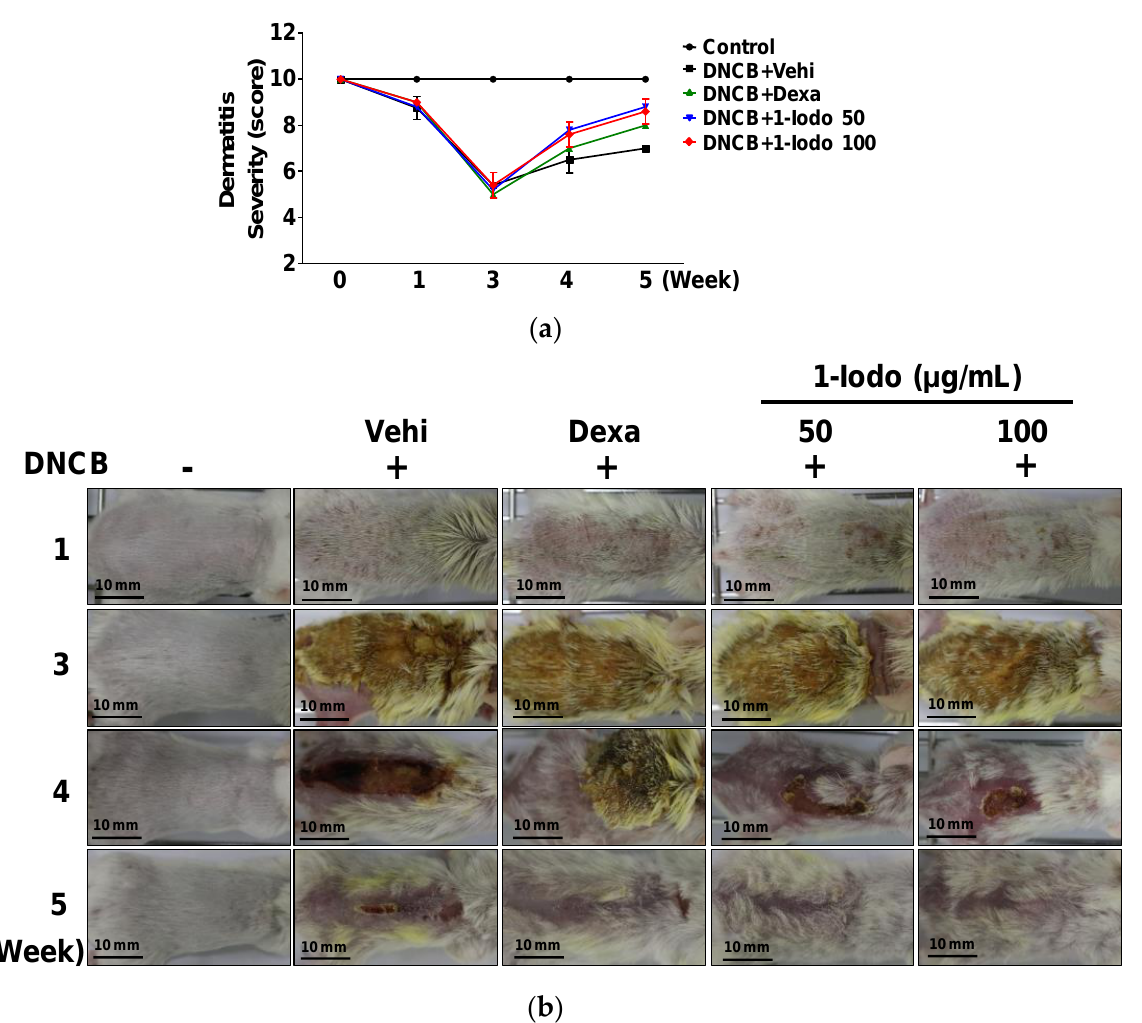
Figure 4. Changes in AD-like lesion severity by 1-iodohexadecane treatment in DNCB-induced mice. The dorsal skins of mice were treated with 2,4-dinitrochlorobenzene (DNCB) with or without 1-iodohexadecane (1- Iodo; 50 or 100 μg/mL) for 21 days. Skin lesions were observed macroscopically and lesion severities were assessed using SCORAD scores as described in the Materials and Methods section. ( a ) Graph of results shown in panel ( b ). ( b ) Representative pictures showing DNCB-induced AD-like skin symptoms before and after treatments. Scale bar = 10 mm. Dexamethasone (Dexa; 0.1%) was used as a positive control ( n = 5). Control, DNCB-untreated control; Vehi, vehicle (100% olive oil).